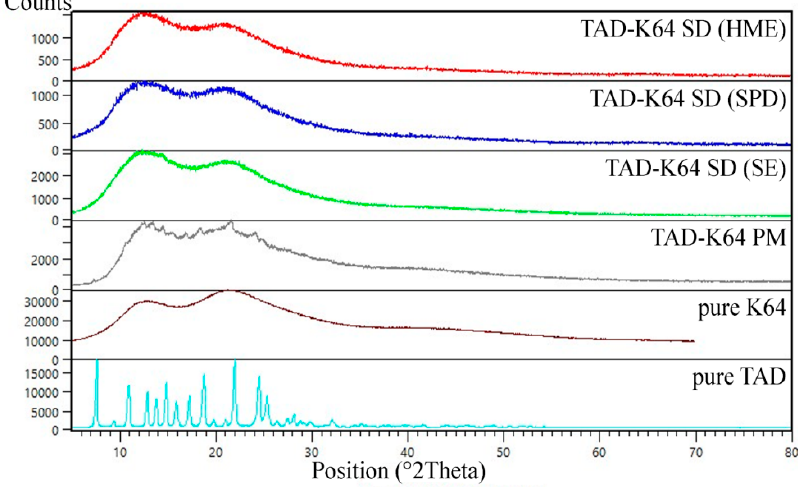
Figure 6. X-ray diffraction patterns of TAD, K64, their PM and SDs.